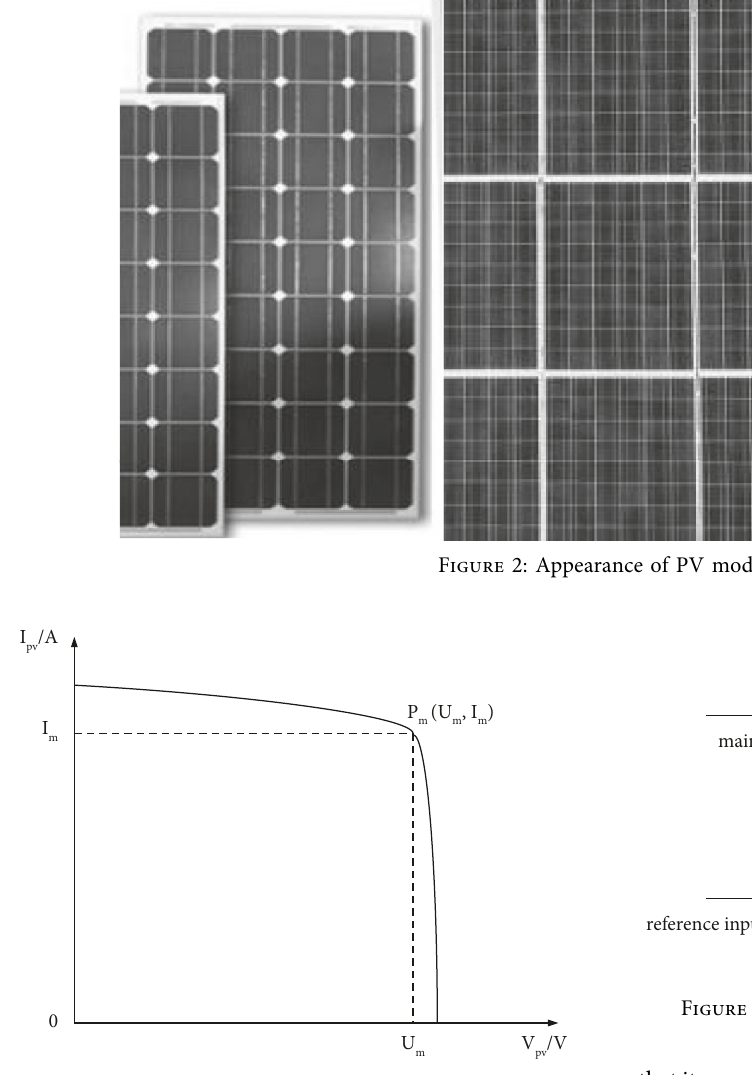
Figure 3: Typical characteristic curve.